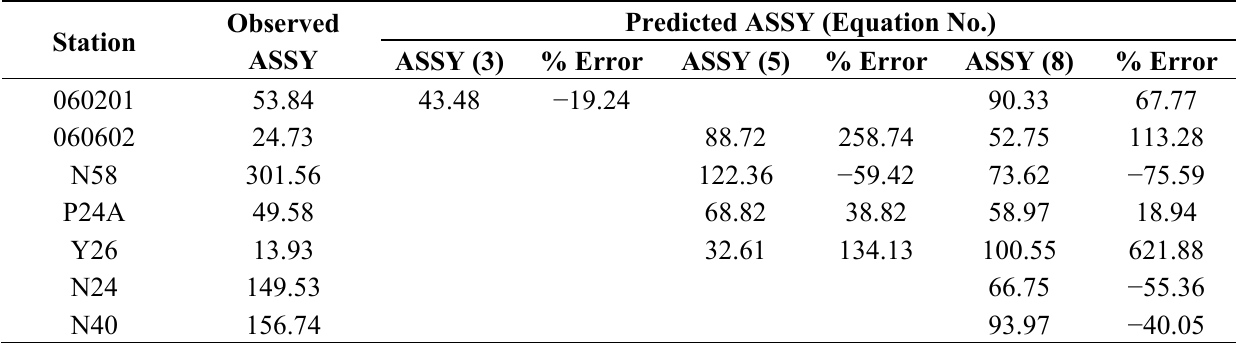
Table 10. Validation results for ASSY prediction.